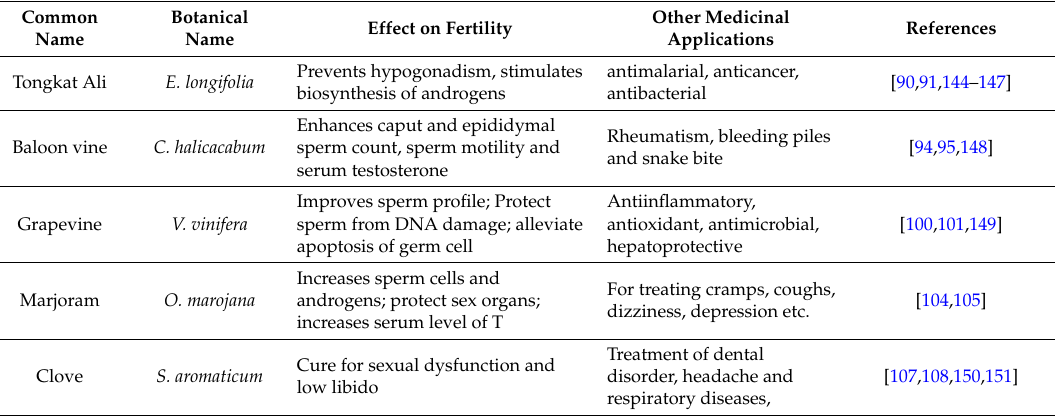
Table 1. Selected plants and their effect on male fertility.